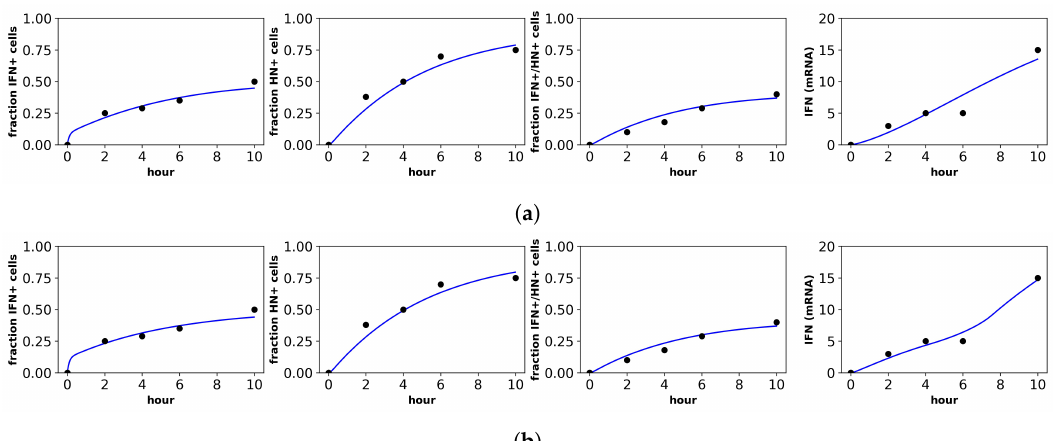
Figure 5. Fit of the extended model to Patil et al.’s dataset. Shown is the fit of our extended model assuming the ( a ) constant secretion rate and ( b ) pulsed secretion rate. Panels, from left to right, show the fraction of cells expressing IFN mRNA, viral HN, both IFN mRNA and viral HN and the average IFN mRNA expression across all cells.